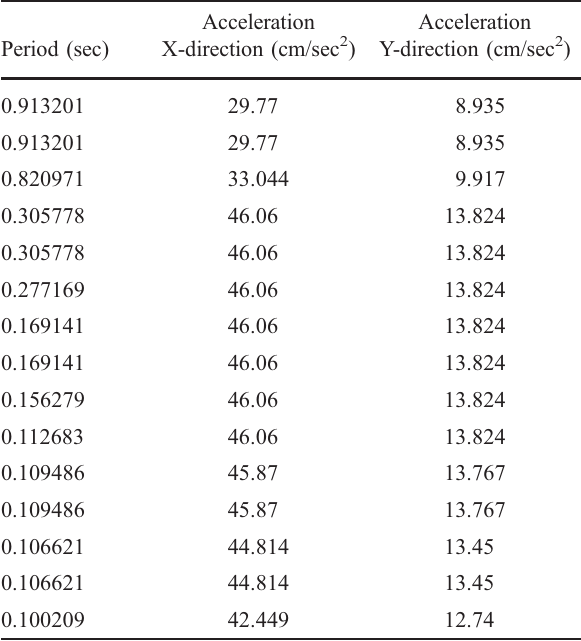
Table 8. Frequency domain modal acceleration for varying period (fixed building)